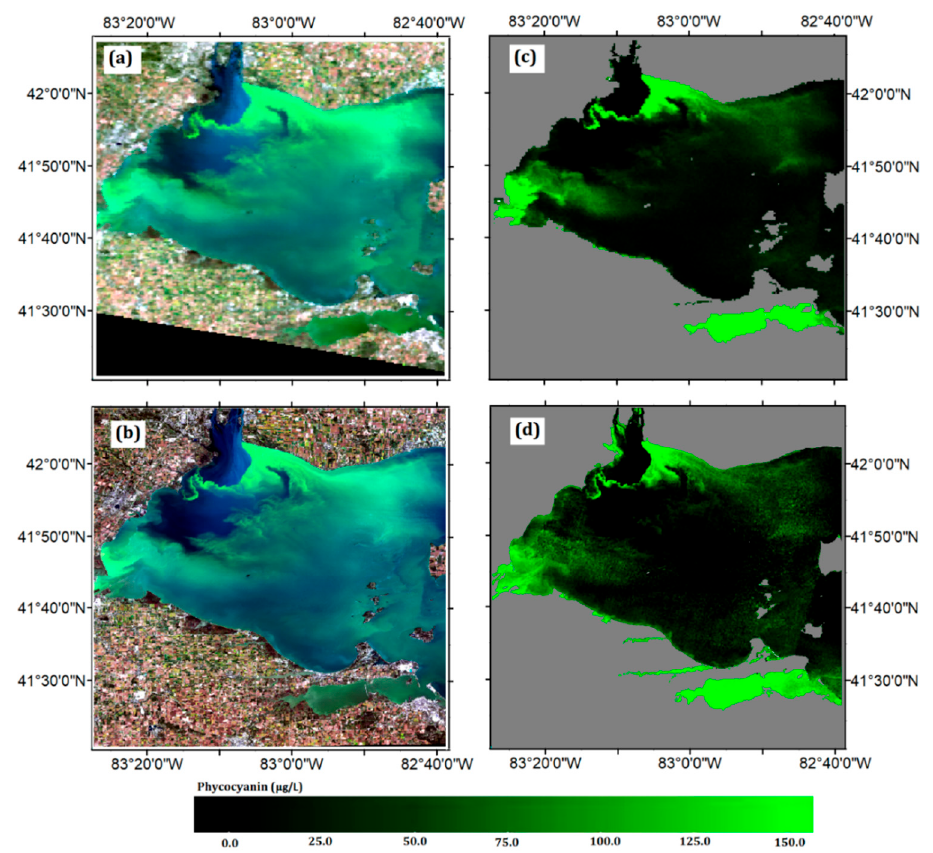
Figure 5. ( a ) LS8-OLI and ( b ) Sen3-OLCI true color images from the same-date (26 September 2017) overpass during a cyanobacteria bloom in Lake Erie. The corresponding PC maps derived using ( c ) OLI and ( d ) OLCI data.